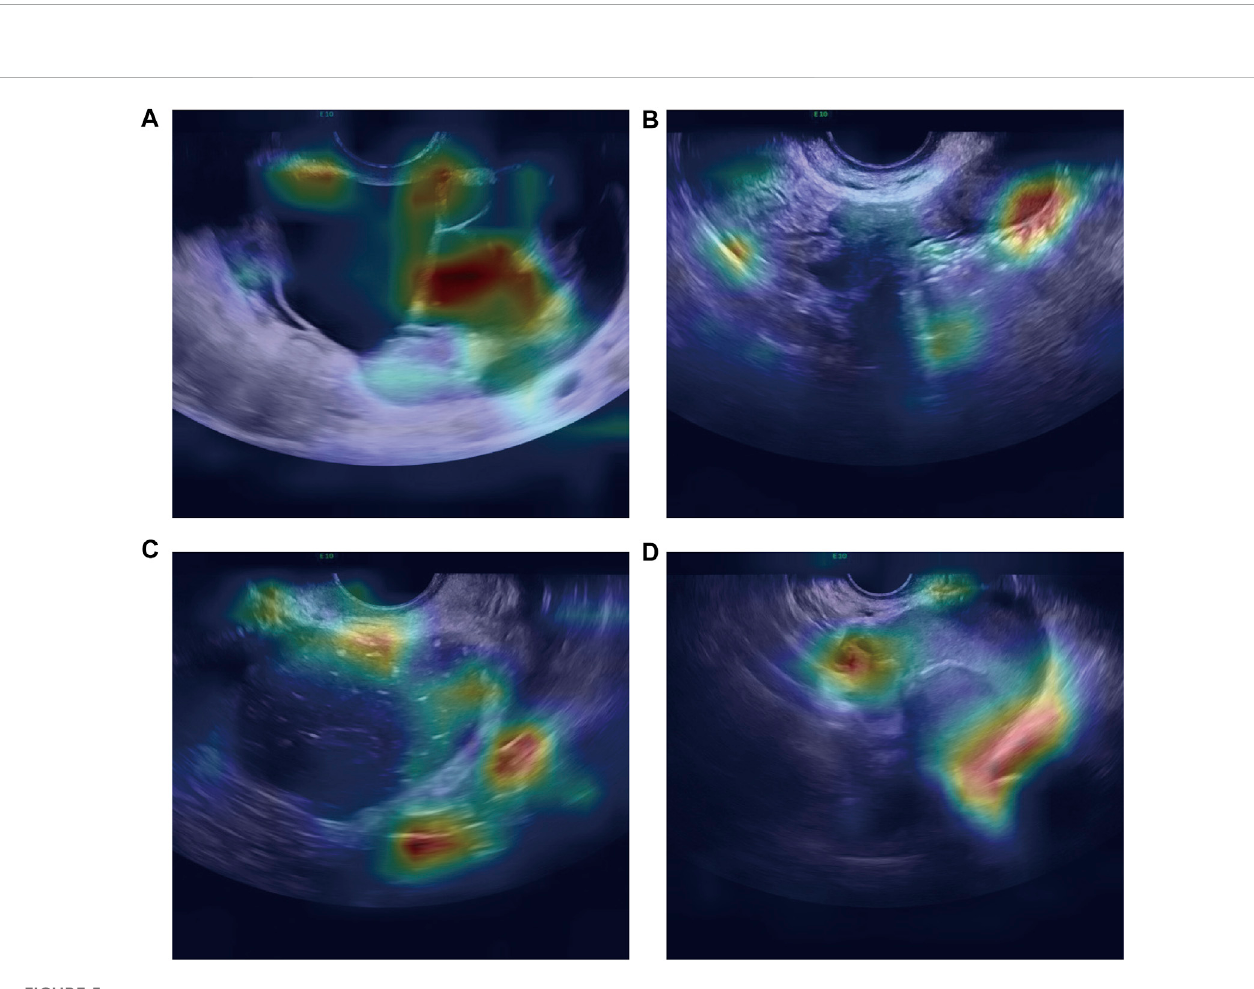
FIGURE 5 Heatmap illustrating the region of interest of the CNN model on OEC class (A,B) and TOA class (C,D) .